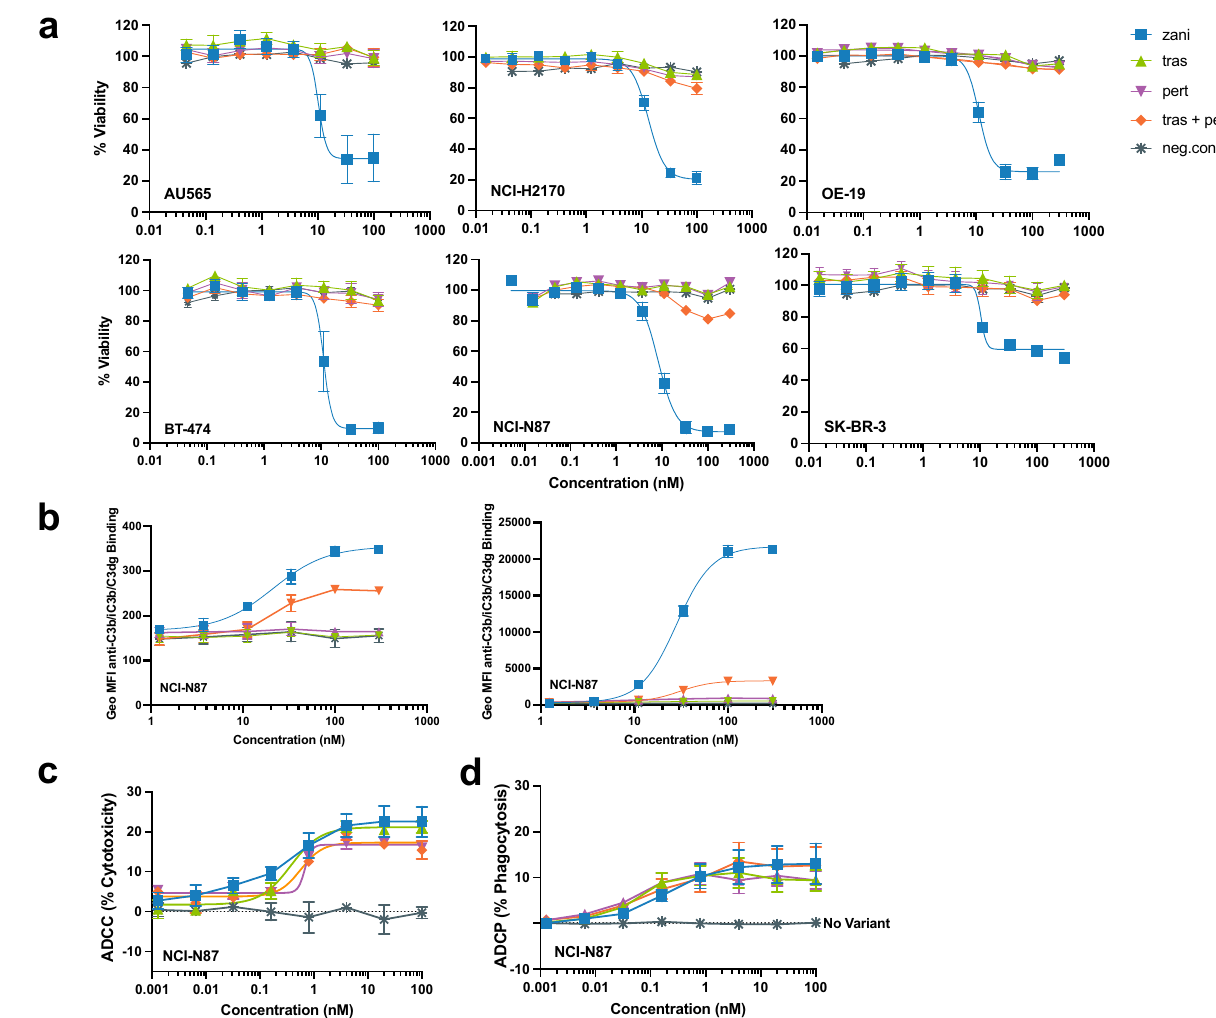
Fig.4|ZanidatamabmediatesFceffectorfunctionsincludingpotentCDC,and ADCC and ADCP. a Zanidatamab mediated CDC with normal human serum (NHS) in high HER2-expressing tumor cells (AU565, NCI-H2170, OE-19, NCI-N87, BT-474, SK-BR-3; HER2 3+) ; trastuzumab, pertuzumab, and tras + pert (1:1) are inactive. b Zanidatamab mediated the highest C1q and C3 fragment (C3b/iC3b/C3dg) deposition on NCI-N87 cells in the presence of NHS. Zanidatamab and tras + pert binding in presence of NHS resulted in enhanced C1q (left) C3b/iC3b/C3dg (right) deposition in NCI-N87 cells compared to trastuzumab, pertuzumab or negative control. Zanidatamab mediated concentration-dependent ADCC ( c ) and ADCP ( d )